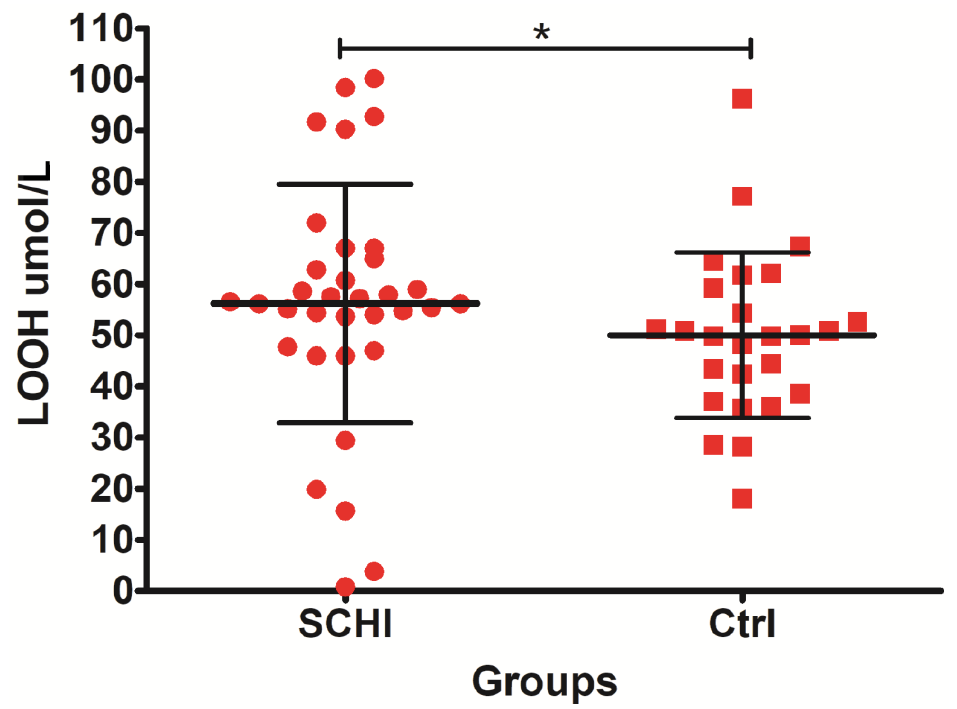
Figure 3. The level of lipid hydroperoxides (LOOH) concentration in the plasma of subjects with schizophrenia compared to the control group. * indicates p -value <